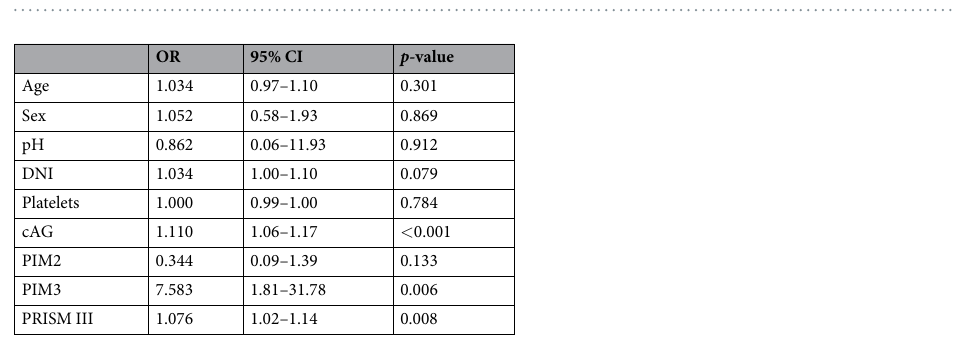
Table 3. Multivariable logistic regression for independent factor in mortality prediction. OR, odds ratio; CI, confidence interval; DNI, delta neutrophil index; cAG, corrected anion gap; PIM, Pediatric Index of Mortality; PRISM III, Pediatric Risk of Mortality